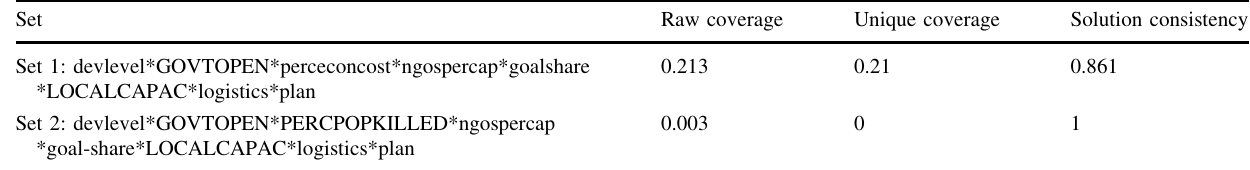
Table 4 Qualitative comparative case (QCA) coverage of factors that produce friction in post disaster management in 18 disaster events in the Americas, Asia, and East Africa